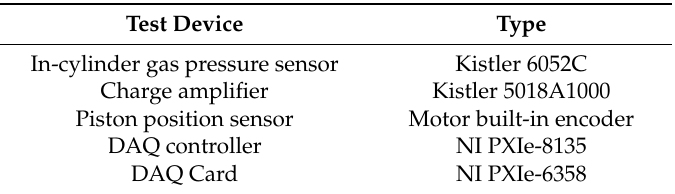
Table 2. Main test devices and